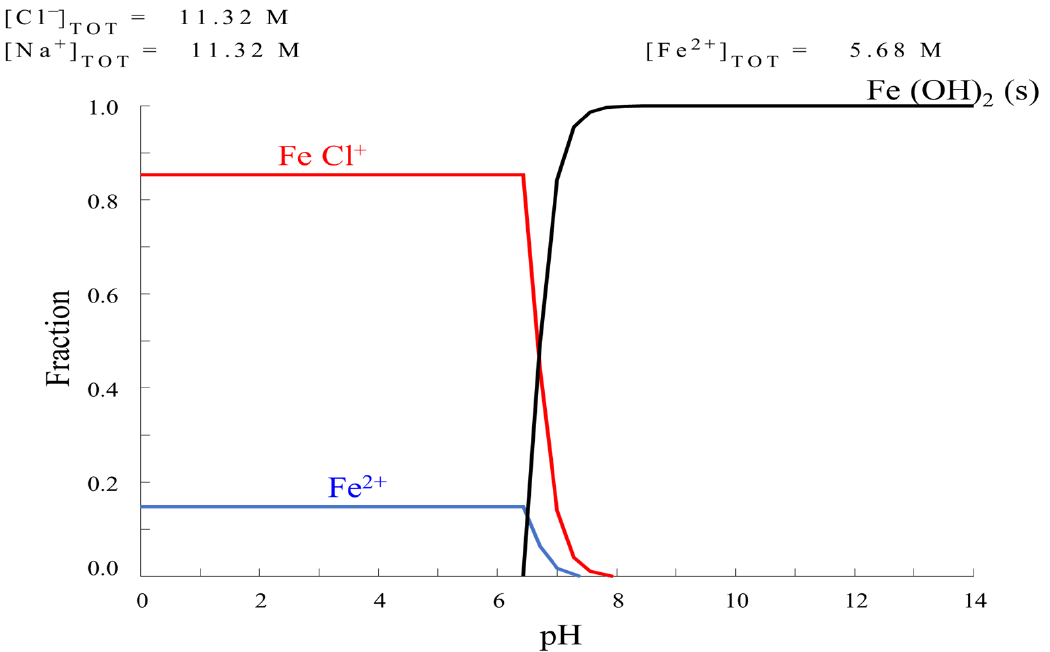
Figure 2. Chemical equilibrium diagram for solution iron/chlorine ratio at 2.0.